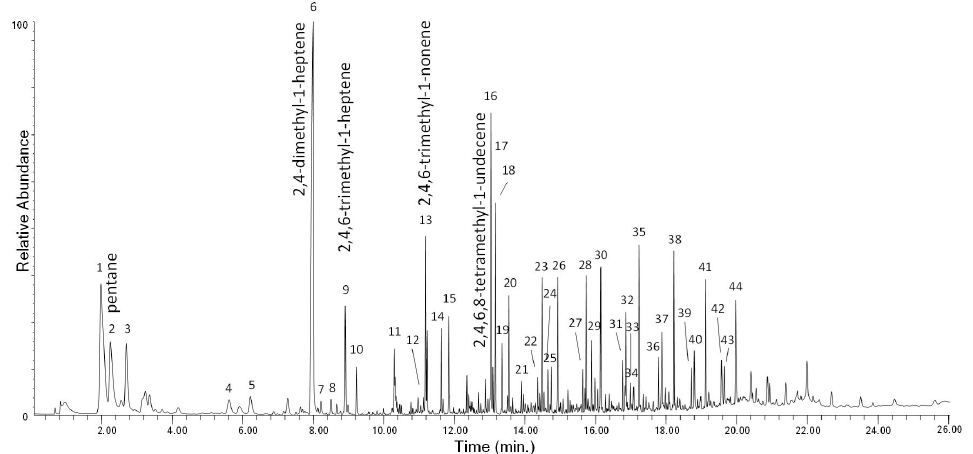
Figure 4. Chromatogram obtained in the pyrolysis–gas chromatography–mass spectrometry (Py–GC–MS) analysis of the unaged PP (PP-0w). Peak identification is reported in Table S1 in Supplementary Materials.